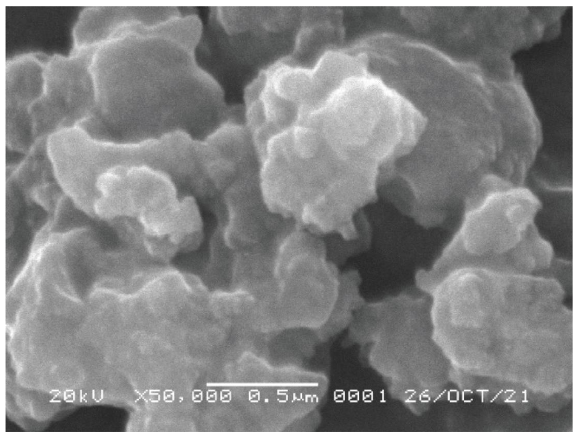
Figure 4: SEM image of Fe